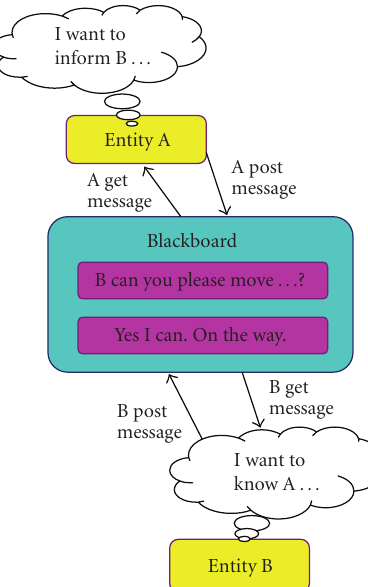
Figure 5: Di ff erent paths generated by probabilistic pathfinding.